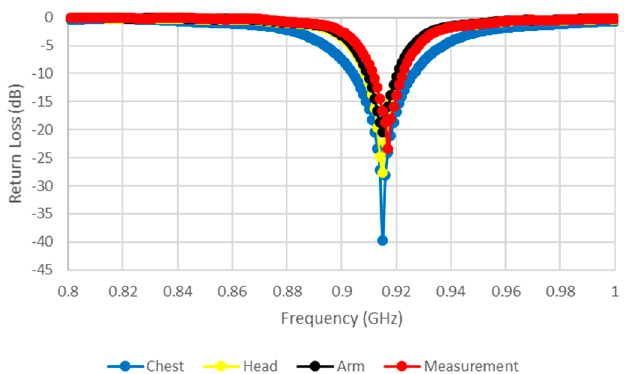
Figure 8. Return losses at three different locations on human body.